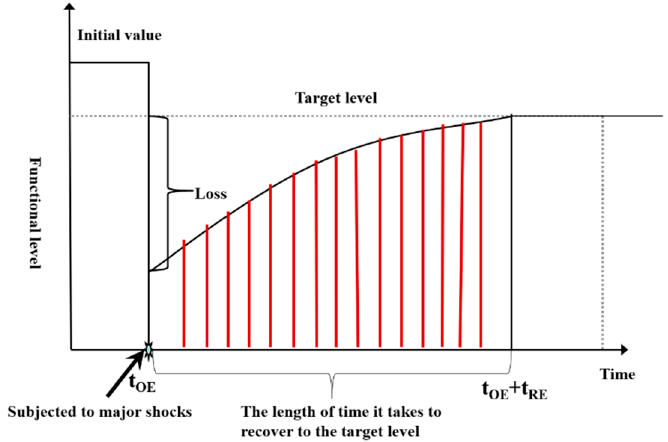
Figure 1. Safety resilience curve.